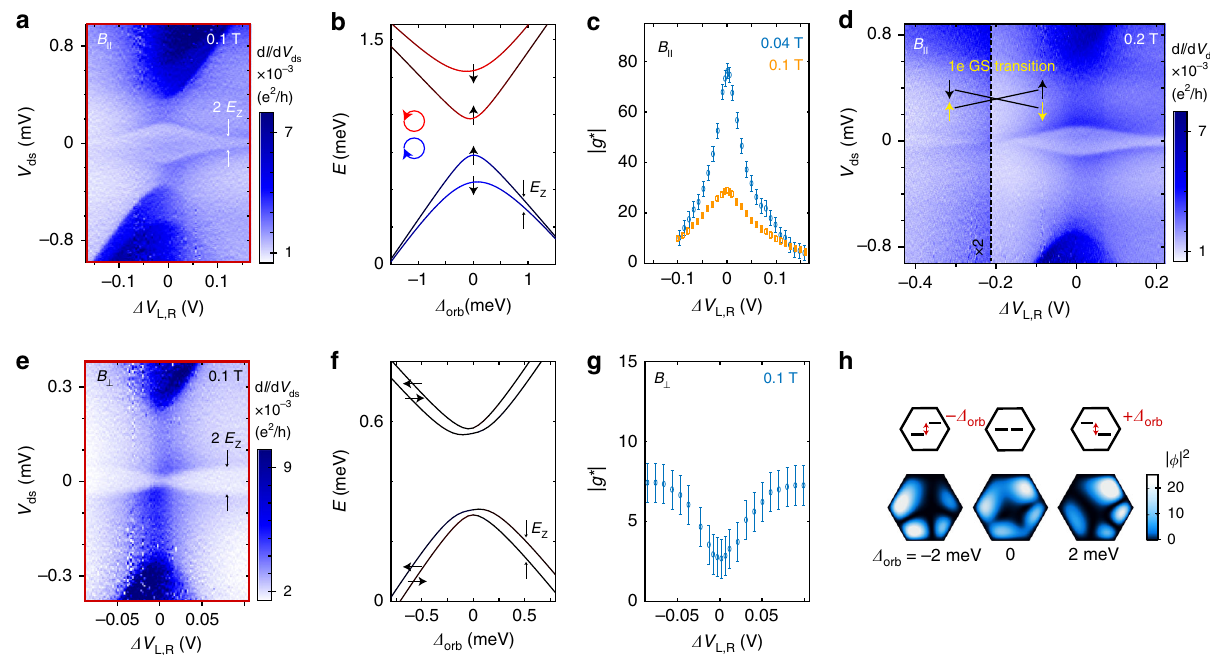
Fig. 4 Quenching the 1e quantum ring by detuning. a Measurement of d I /d V ds versus V ds recorded along the red detuning vector (c.f. Fig. 1f) for B || = 0.1 T. Detuning is de fi ned as Δ V L,R = ( V R − V R0 ) − ( V L − V L0 ), where ( V R0 , V L0 ) are the side-gate voltages when the left and right QD levels are degenerate. E Z denotes the Zeeman splitting. b Numerical calculation of the states for B || = 0.1 T. Here detuning ( Δ orb ) refers to the extrapolated energy difference between the unperturbed orbitals in the left and right QD (see schematic in h ). The colour represents the calculated orbital angular momentum (blue: L z , = − 1.3 ħ , black: L = 0, red: L = 1.3 ħ ). c Experimental values of | g *| for B = 0.04 T (blue) and B = 0.1 T (orange), extracted from the GS-ES1 transition z , z , || || using on a linear approximation. In the case of B || = 0.04 T, | g *| at zero detuning corresponds to | g 1 *|, while we fi nd a strongly reduced value at B || = 0.1 T due to the orbital change of the 1 st excited state. d Same as panel a, but for B || = 0.2 T and a larger detuning range, showing a detuning-induced spin- change of the 1e ground state. e , f Measurement of d I /d V ds and numerical calculation as a function of detuning for B ⊥ = 0.1 T, where SOI from the ring supresses Zeeman splitting. g Experimental values of g * for the GS-ES1 transition at B ⊥ = 0.1 T. h Calculated probability density (| Φ | 2 ) of the lowest energy state at in fi nitesimal B || - fi eld for three different detuning energies. The error bars in c and g represent the uncertainty in energy gap extraction due to measurement noise and orbital crossings, as shown in Supplementary Figs. 5 and 7, where Δ SOI < 0 is found. The 3e case can be understood by considering that the fi rst three states are fi lled, and transitions to the 4th state are probed.